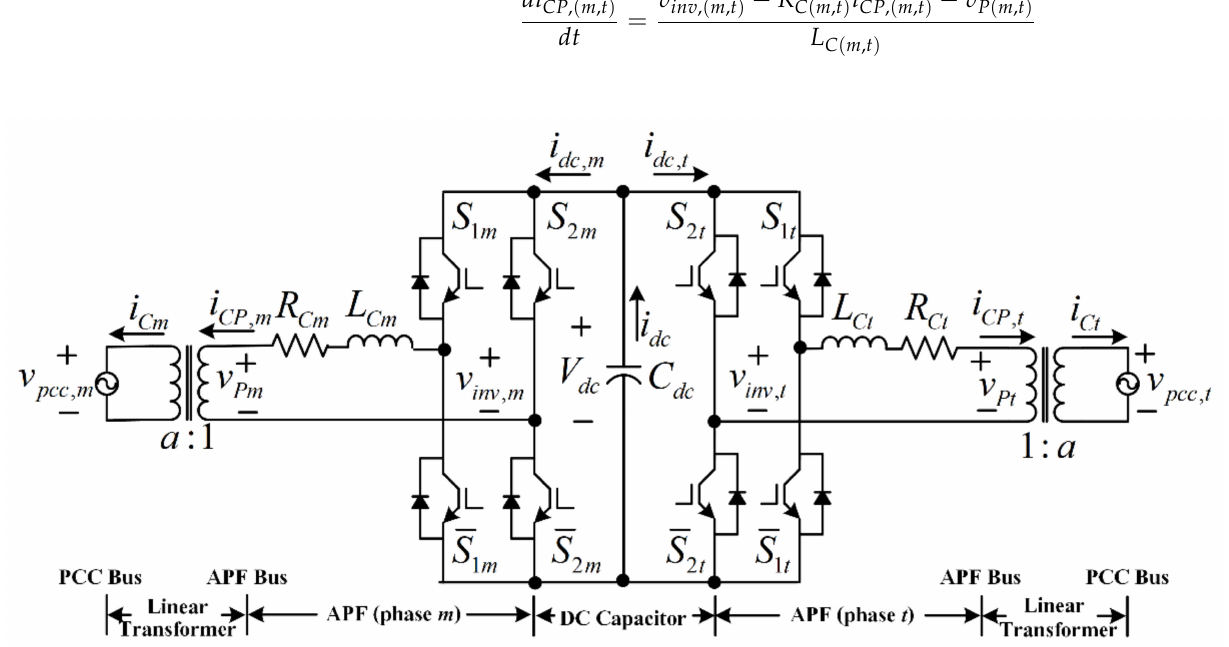
Figure 4. The structure of APF in electric railway